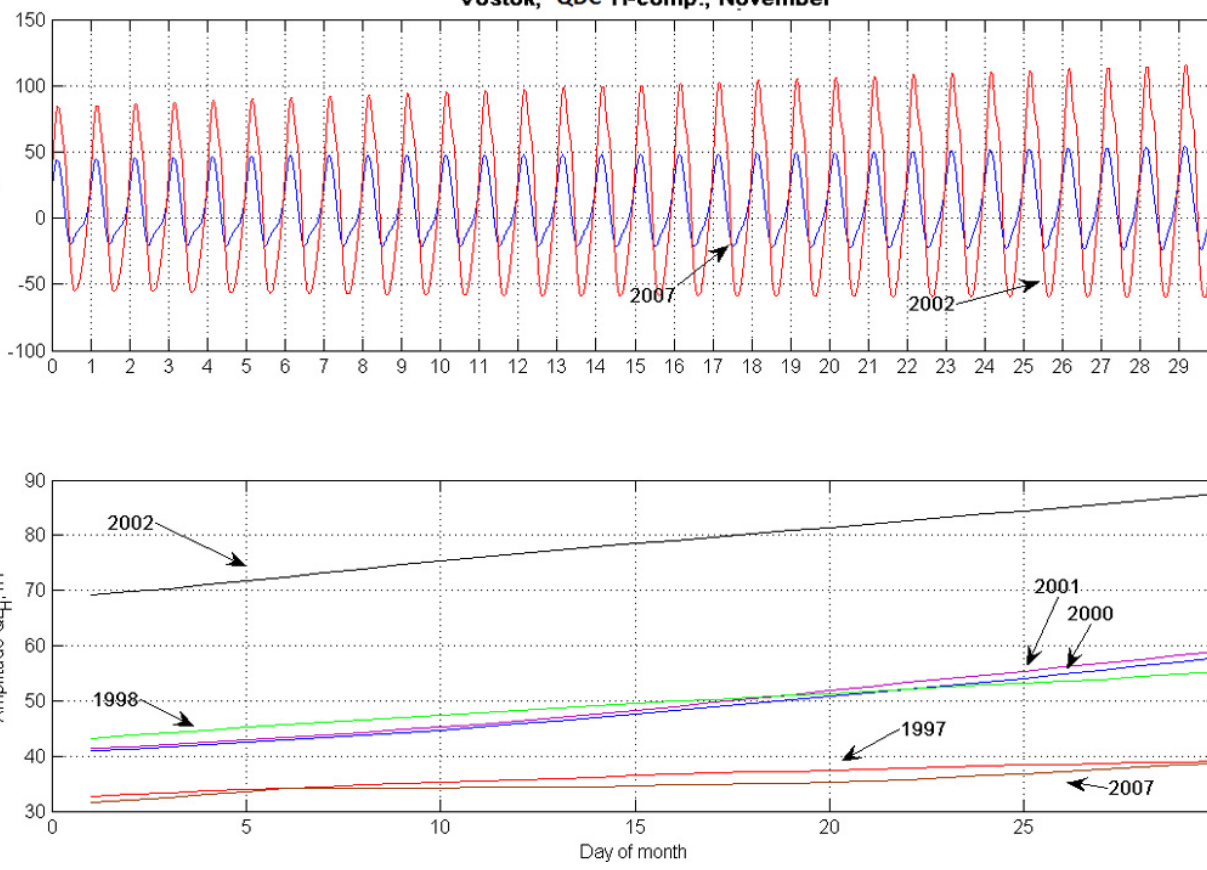
Fig. 4. Variation of the QDC in the H component at Vostok station for Novembers of 2002 and 2007 (upper panel) and the QDC amplitude trends during November months for several years of the solar cycle (lower